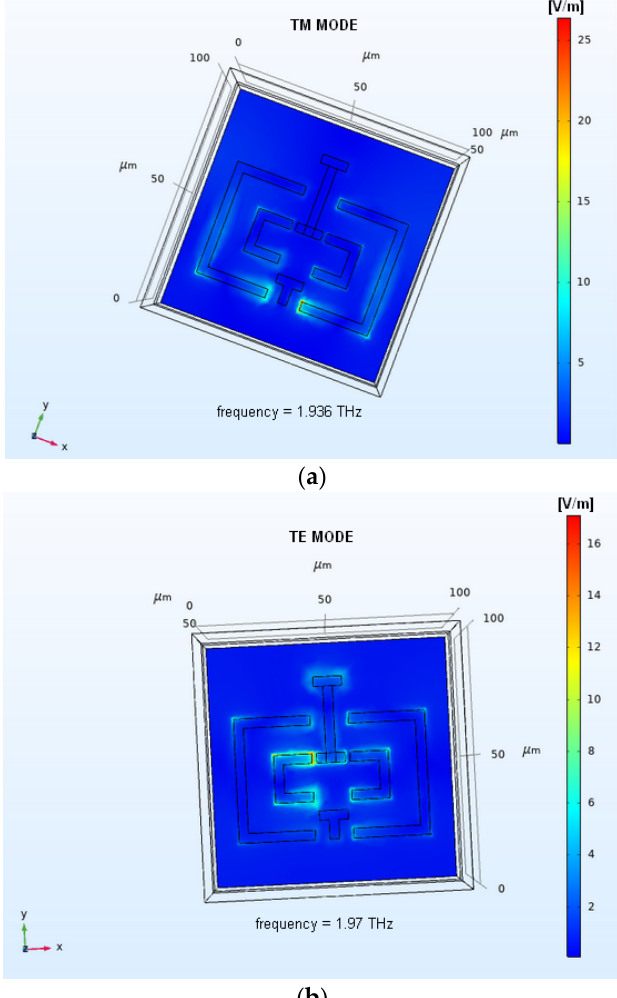
Figure 11. Resonant frequency change as a function of permittivity of an additional layer—2D plot in case of: ( a ) TM mode, ( b ) TE mode.